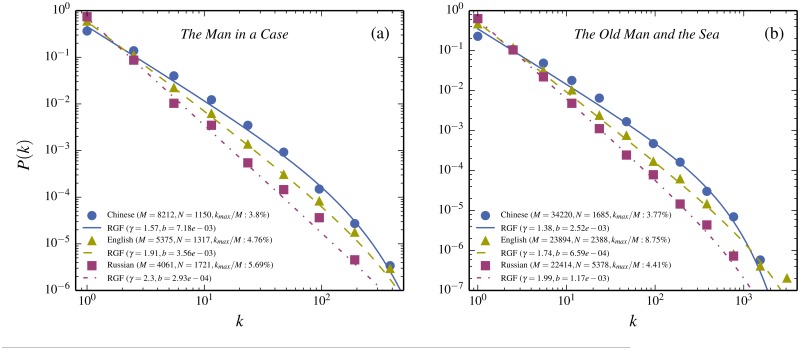
Similarity of translation between words and characters versus words of different languages.(a) The Russian short story The Man in a Case by A. Chekhov, and its translations into English words and Chinese characters (triangles, squares, and filled dots, respectively). The RGF-predictions are given by the curves (dashed dotted, dashed, and full, respectively, The RGF-prediction completely characterizes a frequency distribution in terms of the total number of words/characters (M), the number of specific words/characters (N), and how many of the total number of words/characters are given by the most common word/character (k
max/M). Each such triple (M, N, k
max) gives a unique prediction-curve [(M, N, k
max) = (4061, 1721, 231), (5375, 1317, 256), and (8212, 1150, 312), respectively]. The agreement shows that words and characters are entirely analogous with respect to frequency distributions. (b) illustrates the same thing starting from the English novel The Old Man and the Sea and translating into Russian words and Chinese characters. The triples are this time (M, N, k
max) = (22414, 5378, 988), (23894, 2388, 2091), and (34220, 1685, 1289), in the order Russian, English and Chinese characters (Data points and RGF-curves, as in (a)).